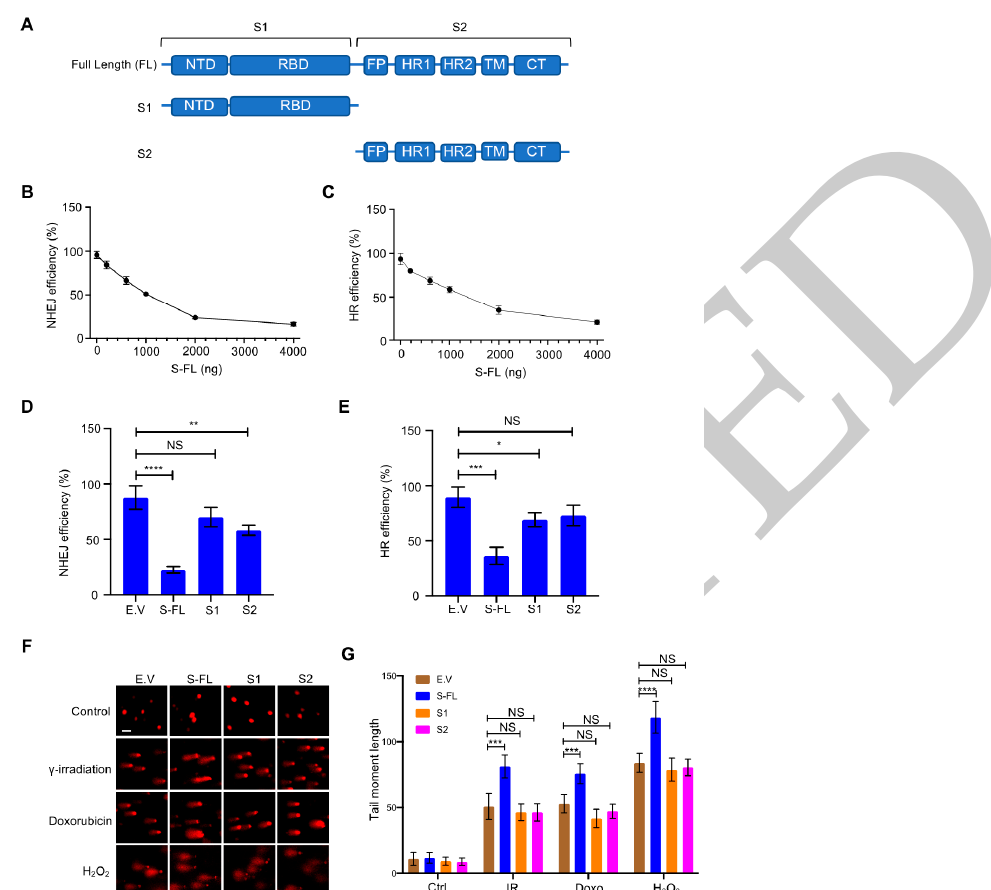
Figure 2. Severe acute respiratory syndrome coronavirus 2 (SARS–CoV–2) spike protein inhibits DNA damage repair. ( A ) Schematic of the primary structure of the SARS–CoV–2 spike protein. The S1 subunit includes an N–terminal domain (NTD, 14–305 residues) and a receptor–binding domain (RBD, 319–541 residues). The S2 subunit consists of the fusion peptide (FP, 788–806 residues), heptapeptide repeat sequence 1 (HR1, 912–984 residues), HR2 (1163–1213 residues), TM domain (TM, 1213–1237 residues), and cytoplasm domain (CT,1237–1273 residues). ( B , C ) Effect of titrated expression of the spike protein on DNA repair in HEK–293T cells. ( D , E ) Only full-length spike protein inhibits non-homologous end joining (NHEJ) and homologous recombination (HR) DNA repair. The values represent the mean ± SD from three independent experiments (see representative FACS plots in Figure S4A,B). ( F ) Full–length spike (S–FL) protein–transfected HEK293T cells exhibited more DNA damage than empty vector-, S1–, and S2–transfected cells under different DNA damage conditions. For doxorubicin: 4 μ g/mL, 2 h. For γ –irradiation: 10 Gy, 30 min. For H 2 O 2 : 100 μ M, 1 h. Scale bar: 50 μ m. ( G ) Corresponding quantification of the comet tail moments from 20 different fields with n > 200 comets of three independent experiments. Statistical significance was assessed using a two-way analysis of variance (ANOVA). NS (Not Significant): * p > 0.05, ** p < 0.01, *** p < 0.001, **** p < 0.0001.